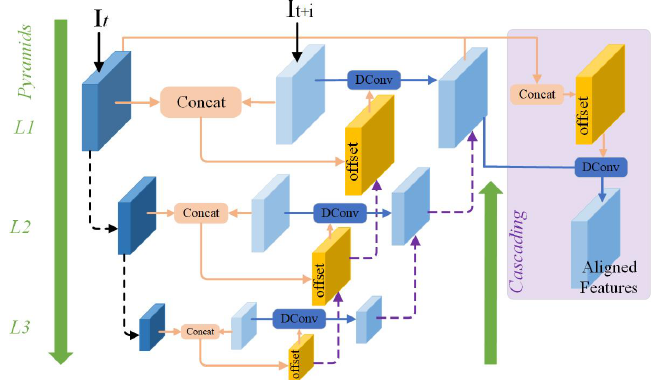
Figure 2. The structure of the PCD module in EDVR [3].